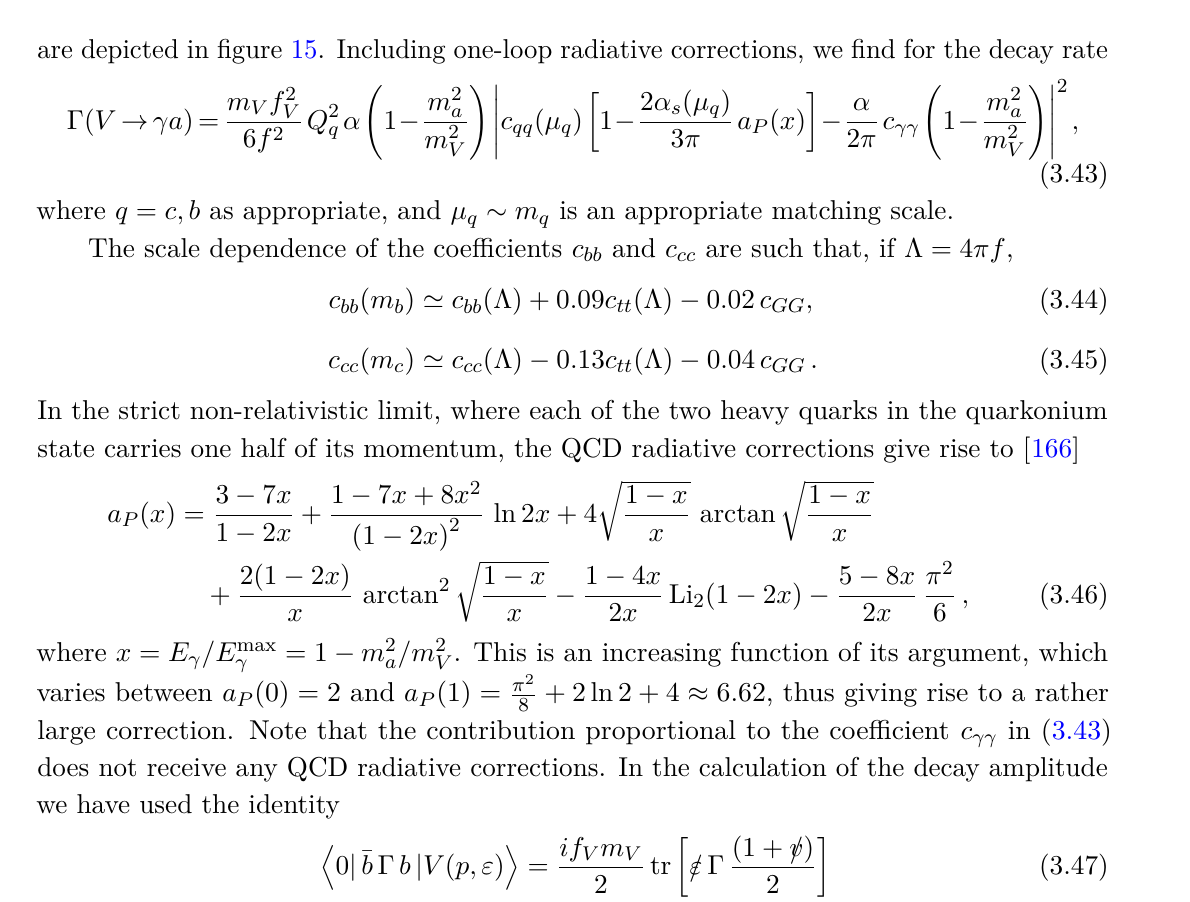
Figure 15 . Diagrams contributing to the decays V → γa of heavy vector